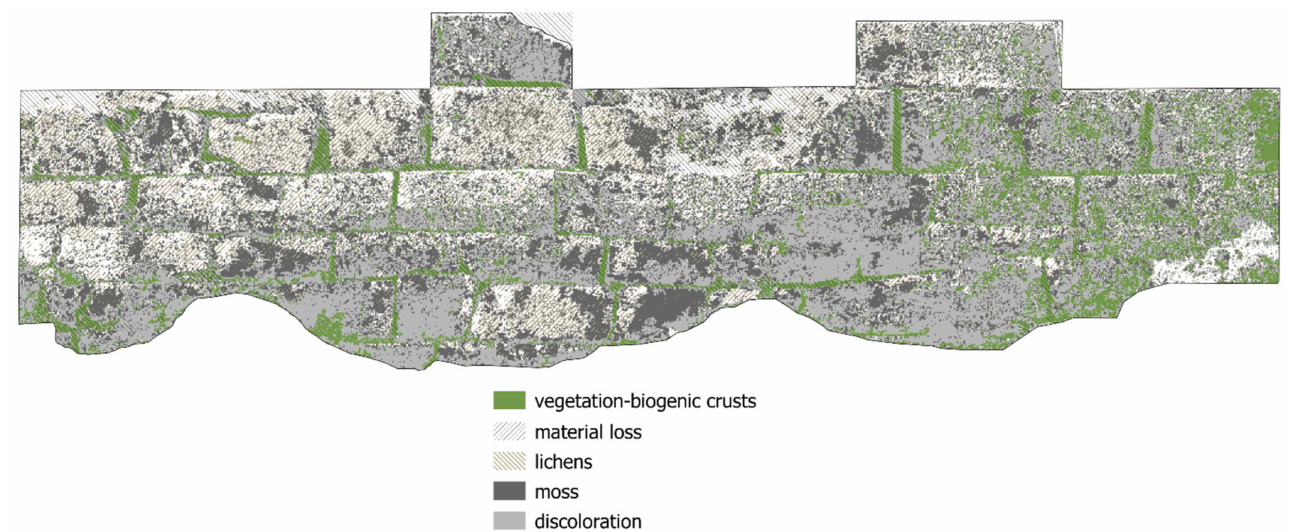
Figure 11. Degradation map, cella wall remains at the Temple of Athena and Zeus Sotiros.